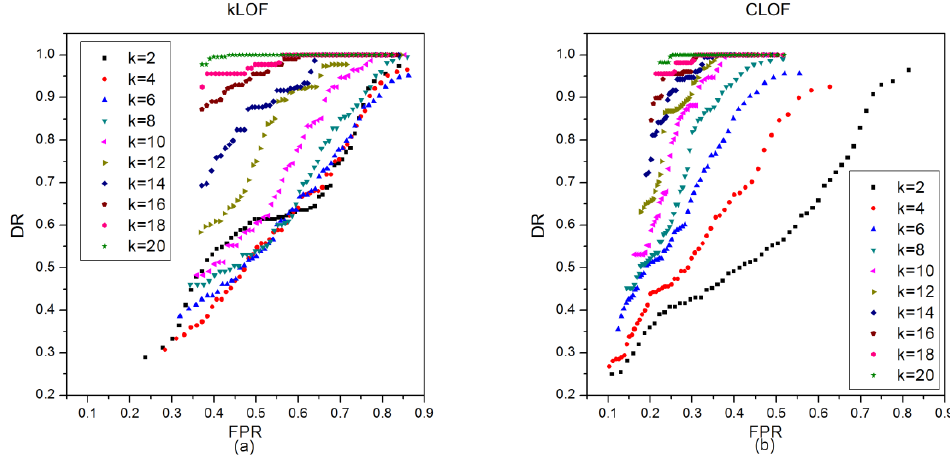
Figure 10. ROC curves of kLOF and CLOF methods on the KDD Cup 1999 dataset with different k related to t : ( a ) the ROC curves of kLOF method; ( b ) the ROC curves of CLOF method.